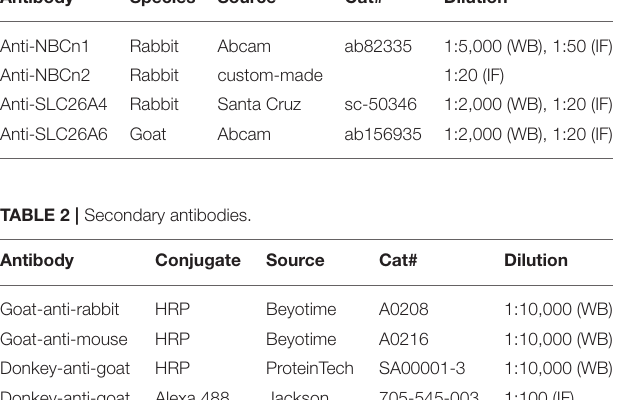
TABLE 1 | Primary antibodies. Antibody Species Source Dilution Anti-NBCn1